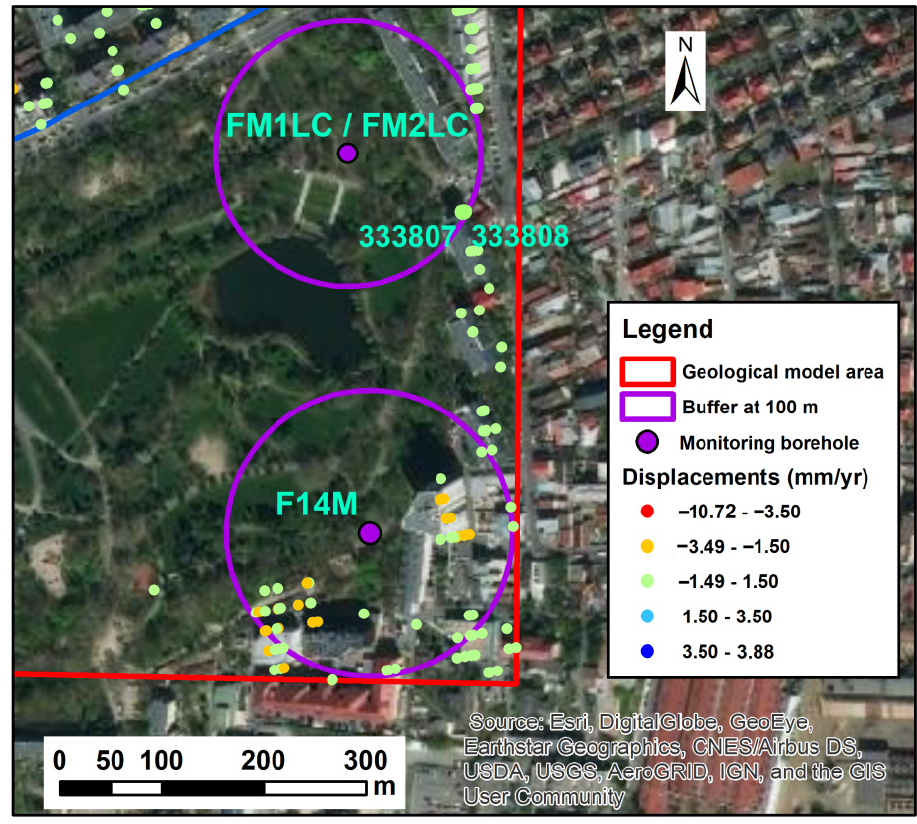
Figure 11. PS points situated within the 100 m buffer zone from FM1LC/FM2LC and F14M monitoring boreholes. Close-related to FM1LC/FM2LC borehole PS points codes: 333807 and 333808. Map generated in Esri ® ArcMap™ 10.3. Base map source: ESRI World Imagery.